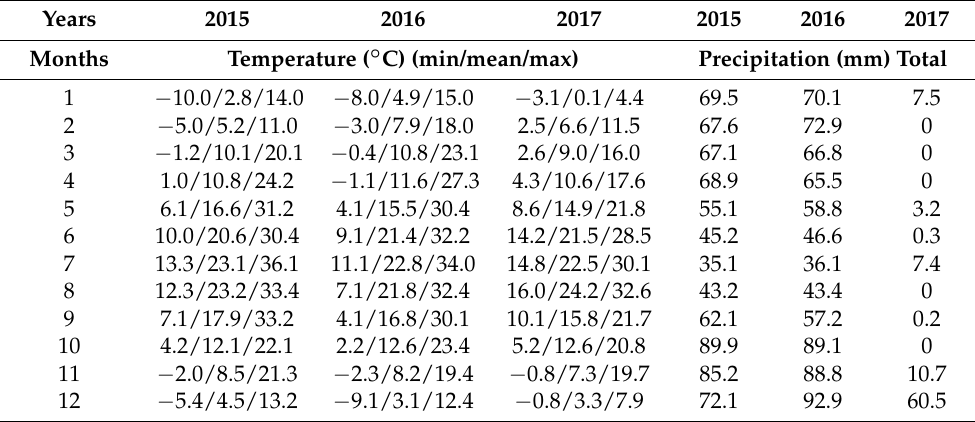
Table 1. Detailed information regarding temperature and precipitation values throughout the years of the study